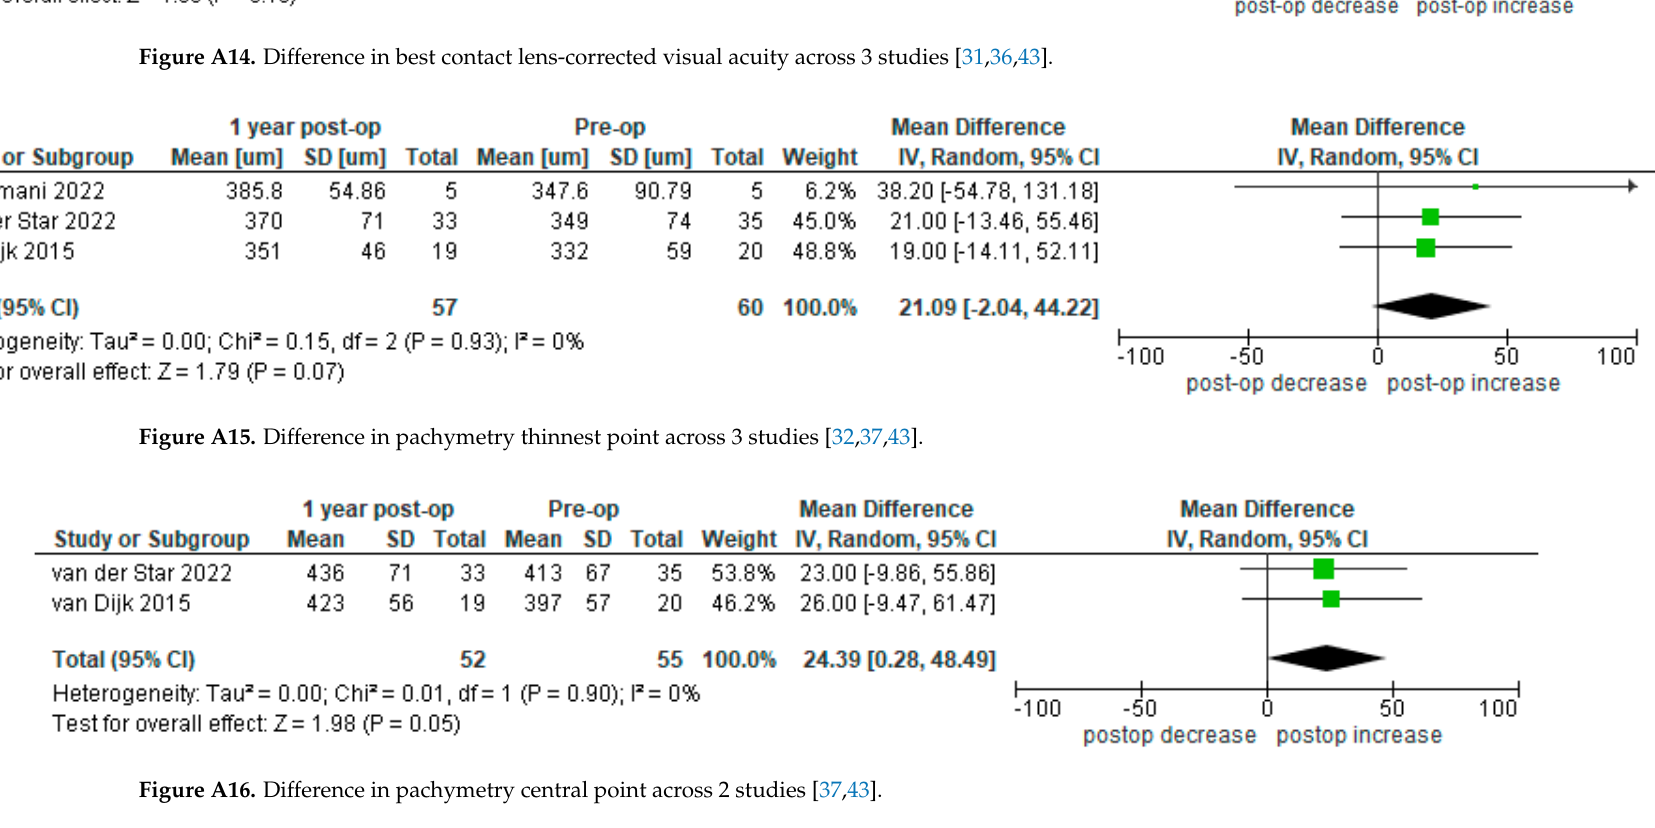
Figure A17. Di ff erence in maximum keratometry across 3 studies [32,37,43]. Figure A18. Di ff erence in mean simulated keratometry across 3 studies [31,32,43].